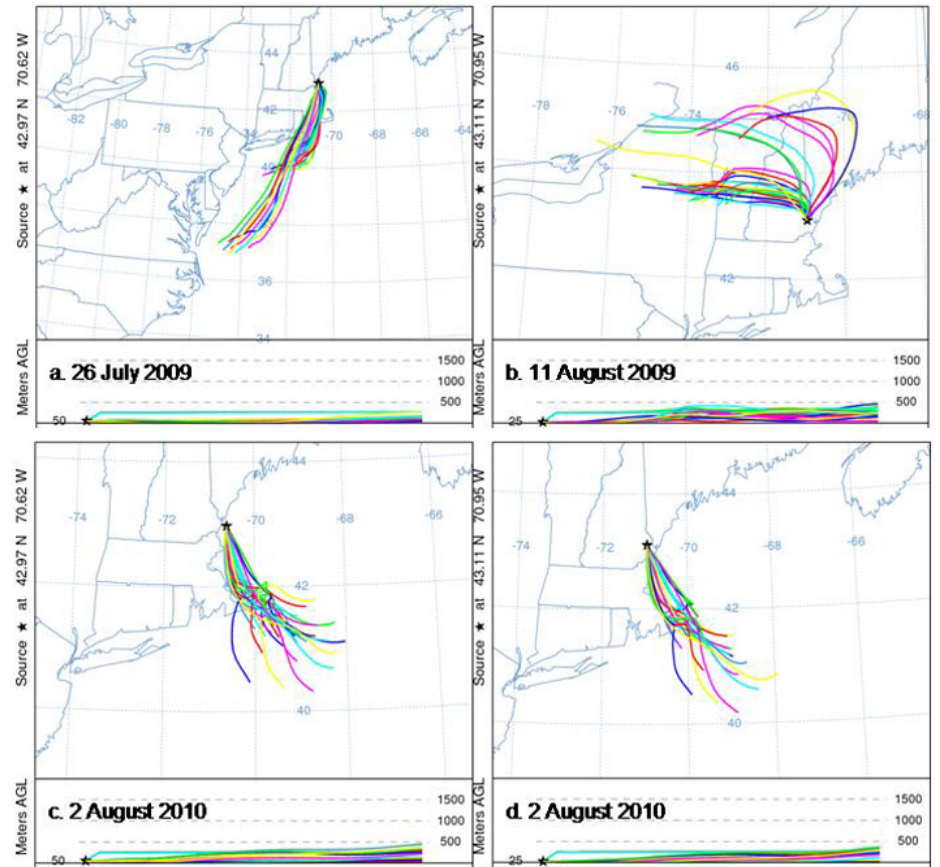
Fig. 7. HYSPLIT backward trajectories for Appledore Island ( (a) 26 July 2009 and (c) 2 August 2010) and Thompson Farm ( (b) 11 August 2009 and (d) 2 August 2010) showing different air parcels affecting the sites during 2009 and similar air parcels during